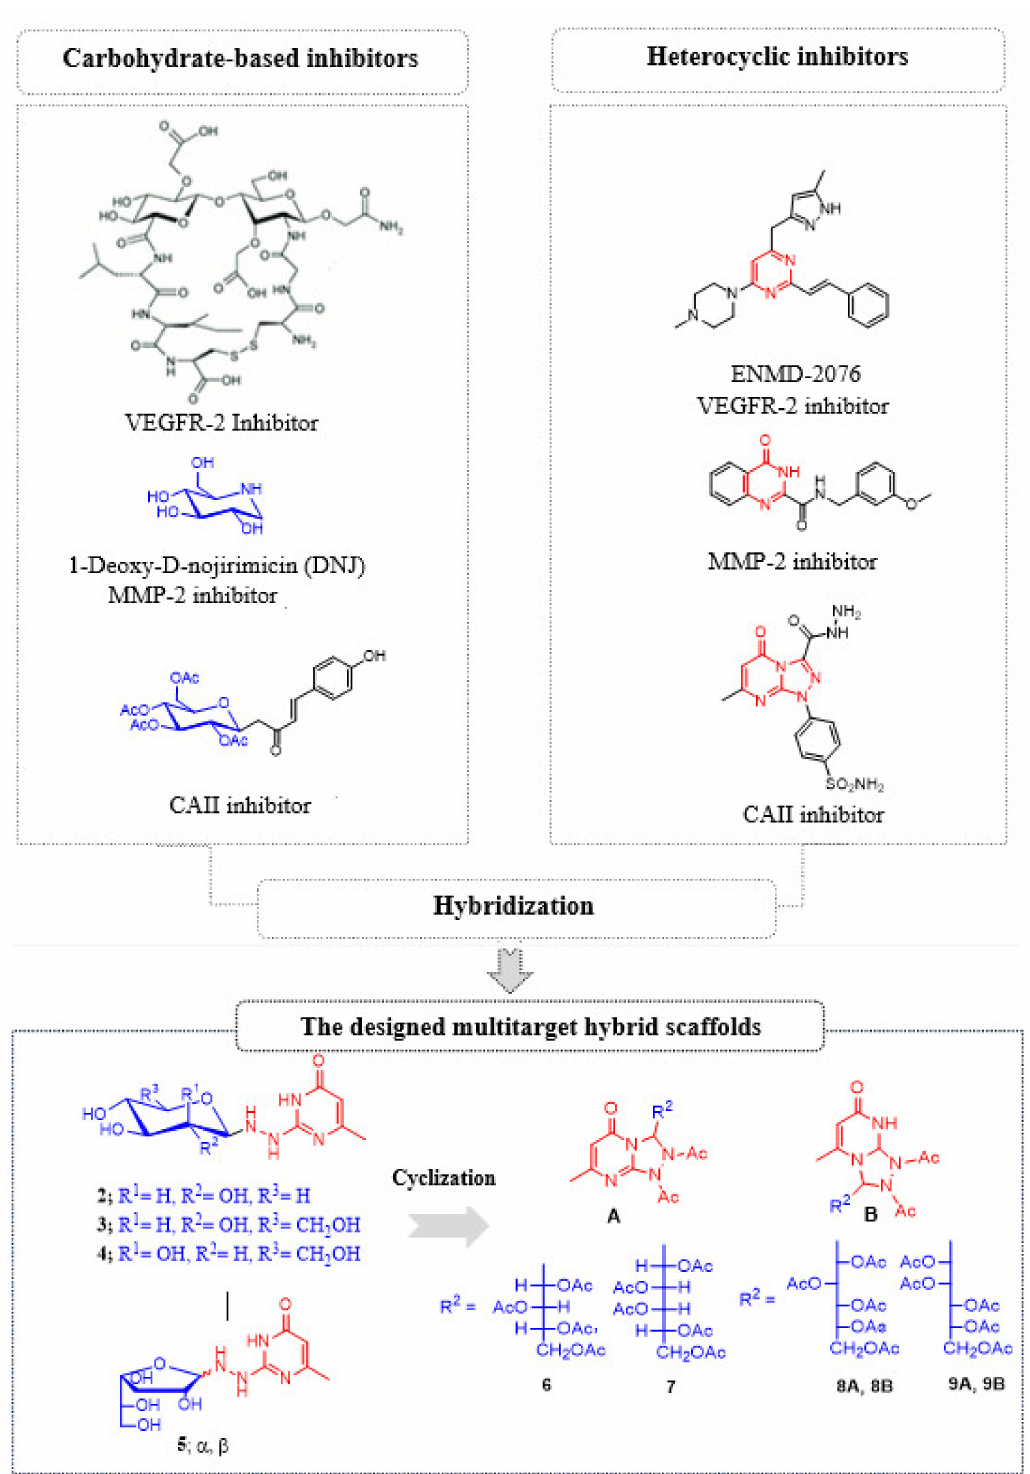
Figure 1. Lead inhibitors [44,47,49,52,53,62,63] and design of the target compounds. Docking was conducted to predict their pharmacophoric features addressing the key interactions with the enzymatic catalytic domains and correlating their binding modes to those of reference